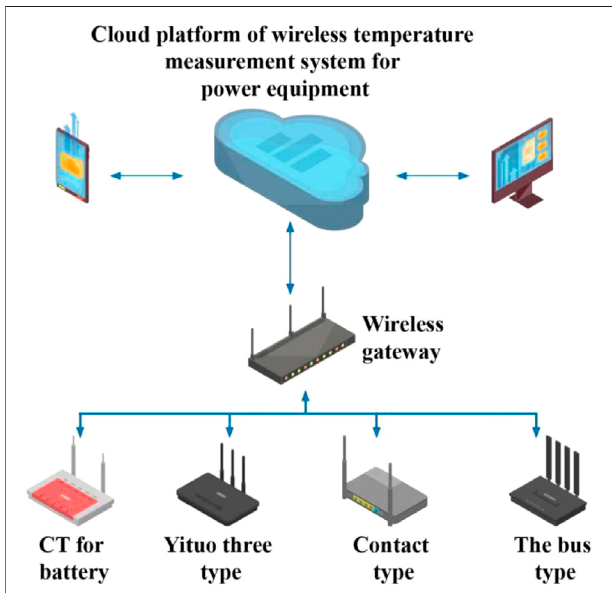
FIGURE 1 | Substation equipment status detection in the cloud